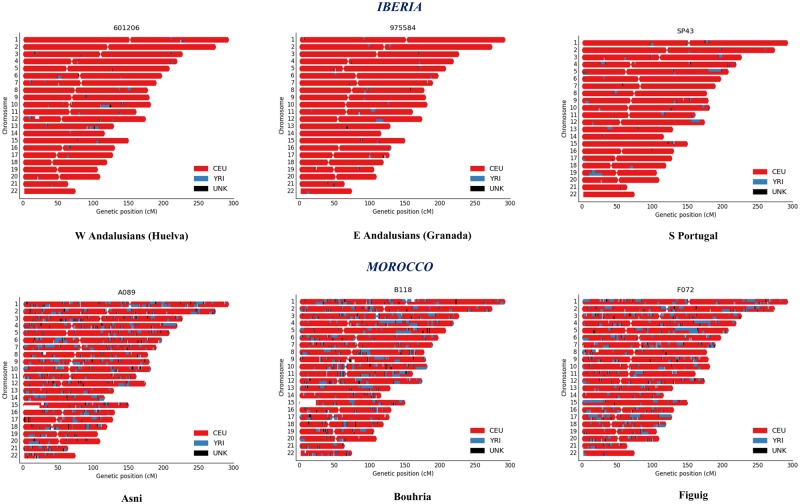
RFMix inferred karyograms in the analyzed populations from southern Iberia and northwestern Africa (Morocco). A representative individual is shown for each population harboring average values of ancestral proportions for both reference panels YRI and CEU.